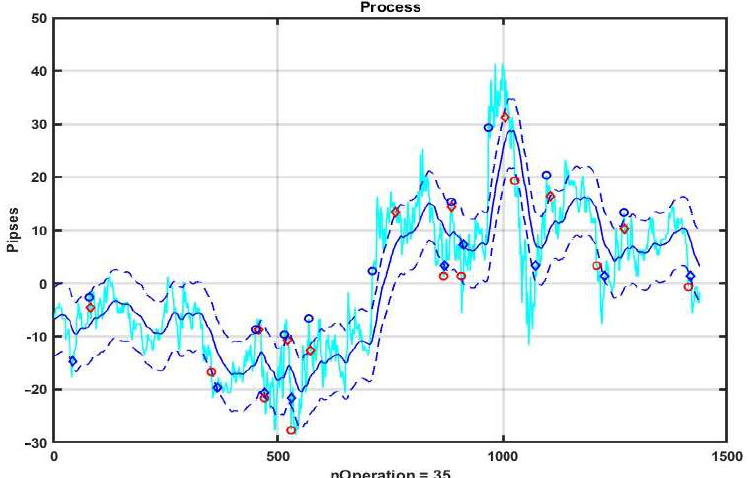
Figure 18. Figure 18. Example implementation of CSB during a single observation day with optimal optional parameters.